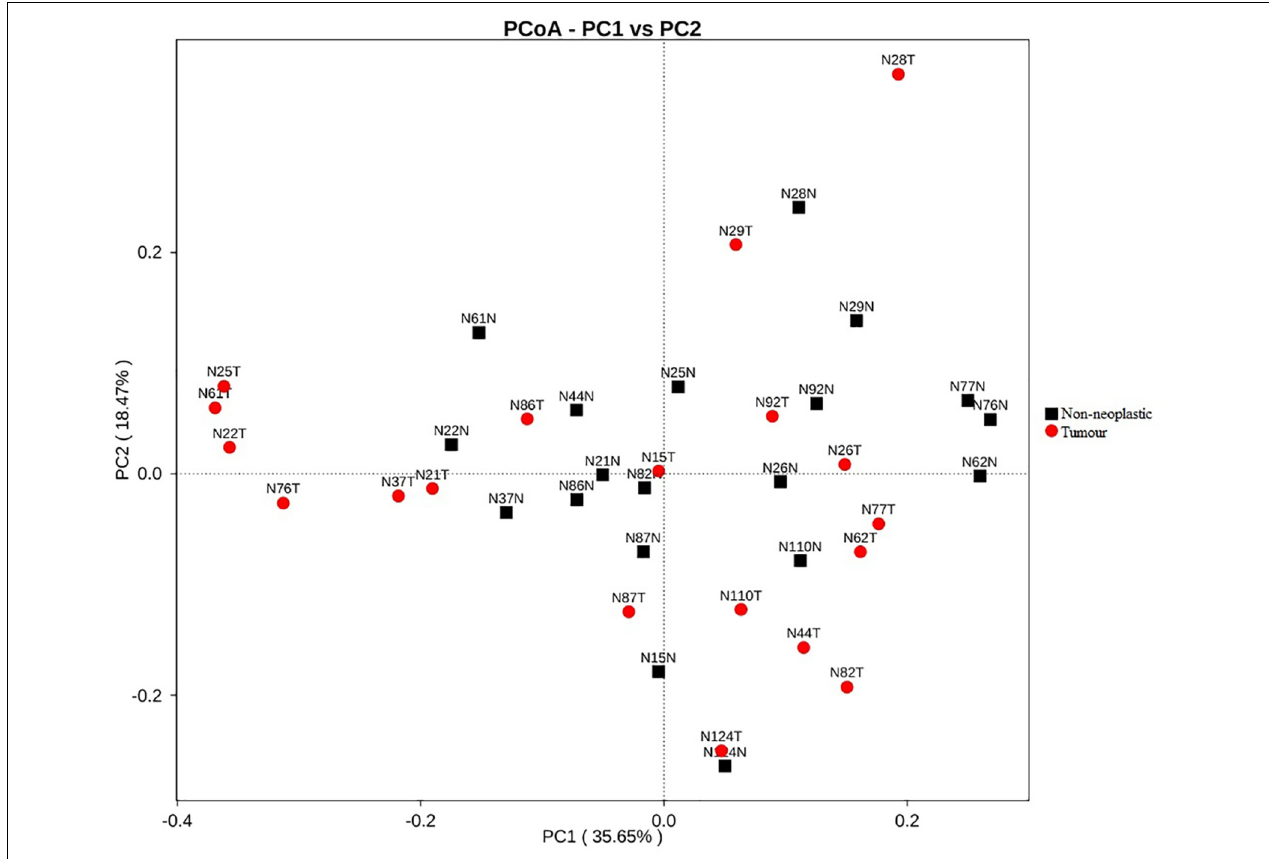
FIGURE 2 | PCoA plots for weighted uniFrac distances of the variation in microbiota composition detected in the tumours and non-neoplastic mucosae.